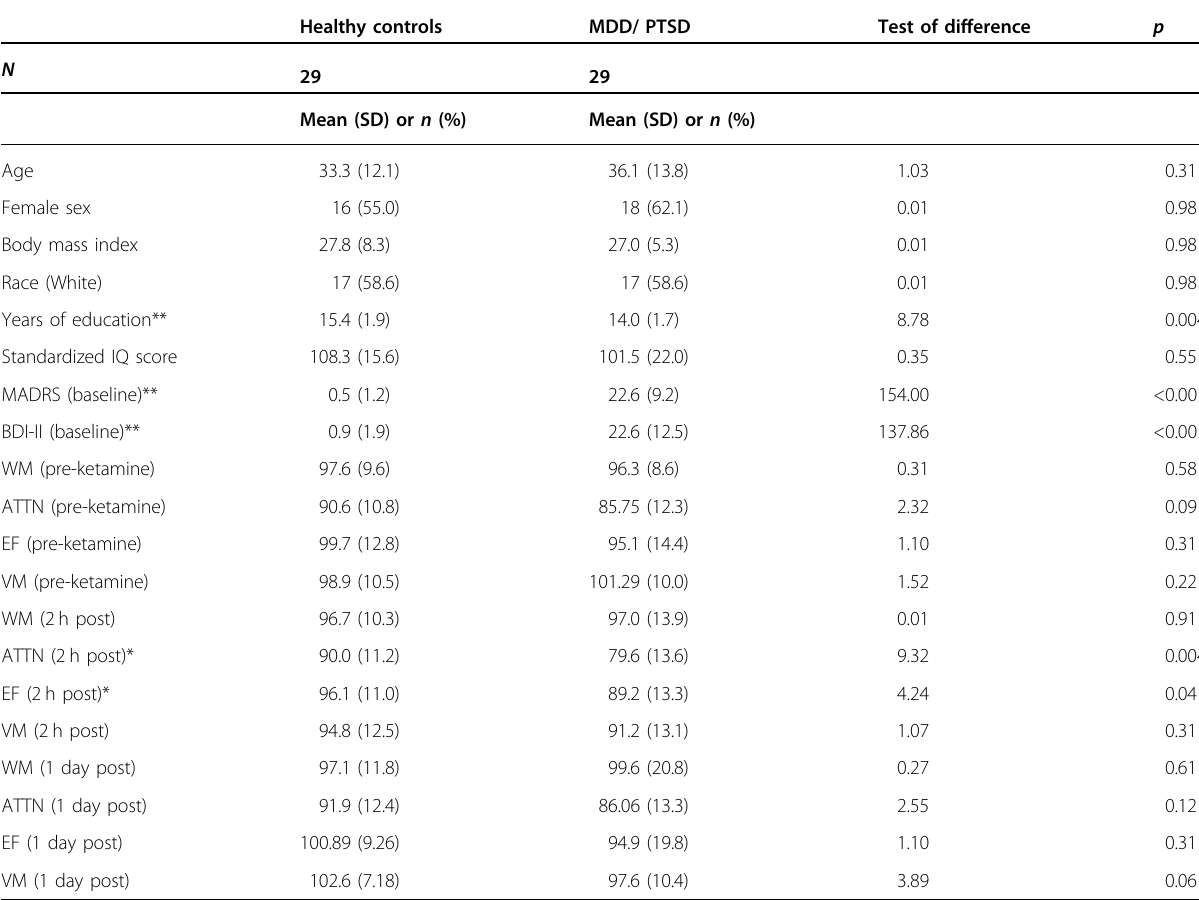
Table 1 Demographic and clinical characteristics of the HC and MDD/PTSD group. Healthy controls MDD/ PTSD Test of